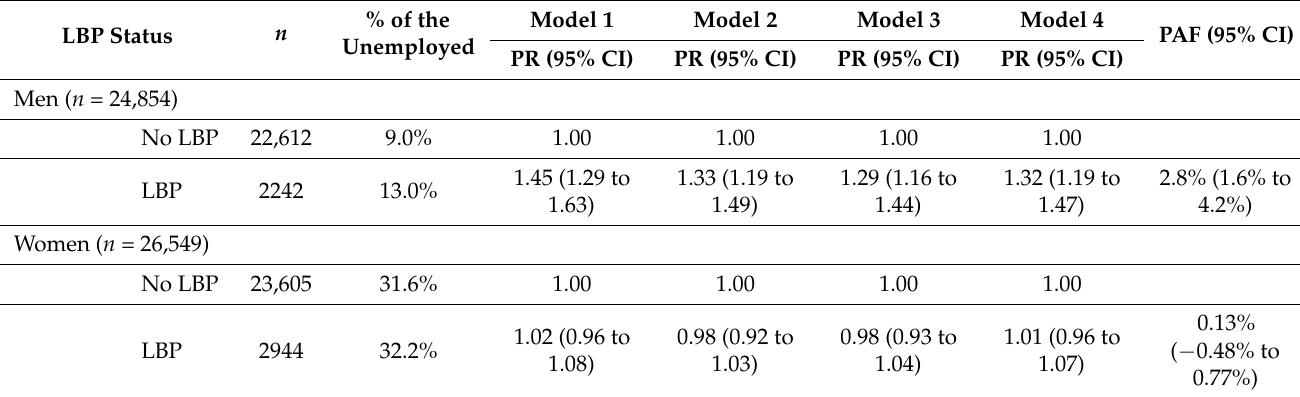
Table 2. Prevalence ratio and population attributable fraction for unemployment associated with self-reported LBP, by